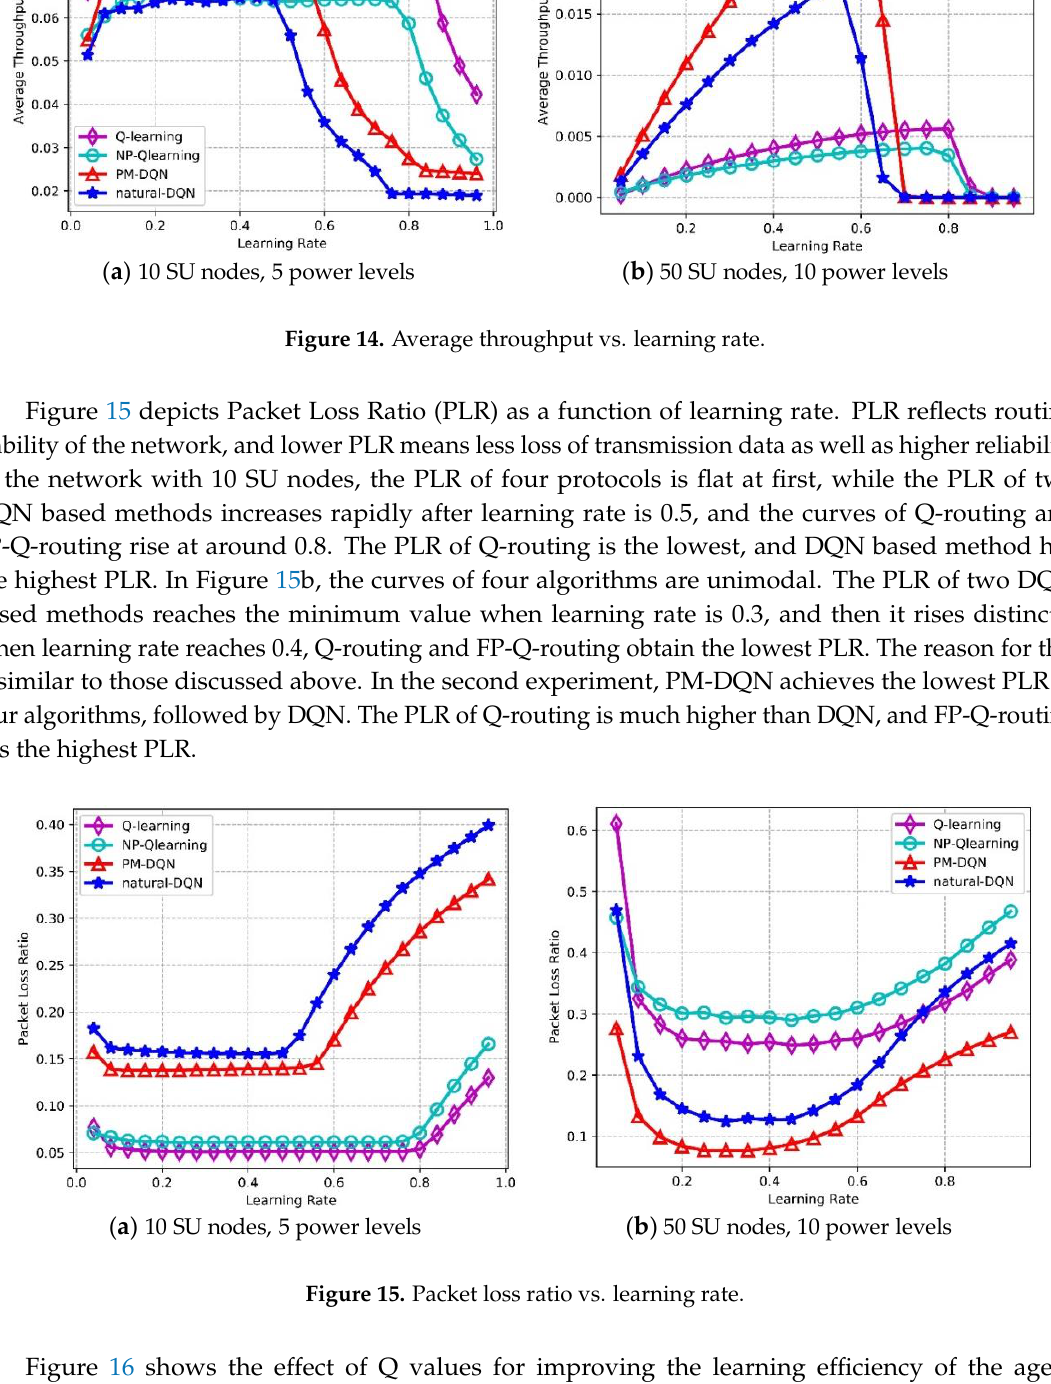
Figure 13. Packet delivery ratio vs. learning rate.